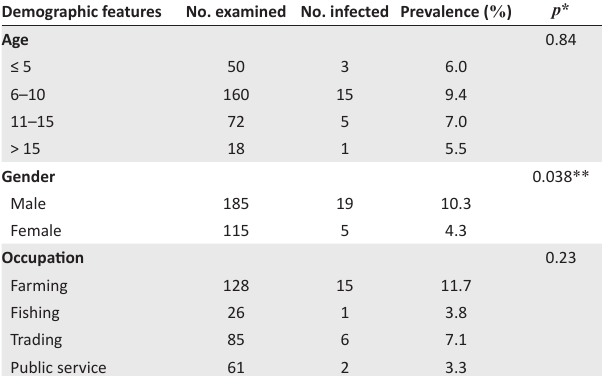
TABLE 2: Demographic distribution of subjects with Schistosoma haematobium infection in Ohaukwu and Ikwo, Nigeria, December 2016. Demographic features No. examined No. infected Prevalence ( % )